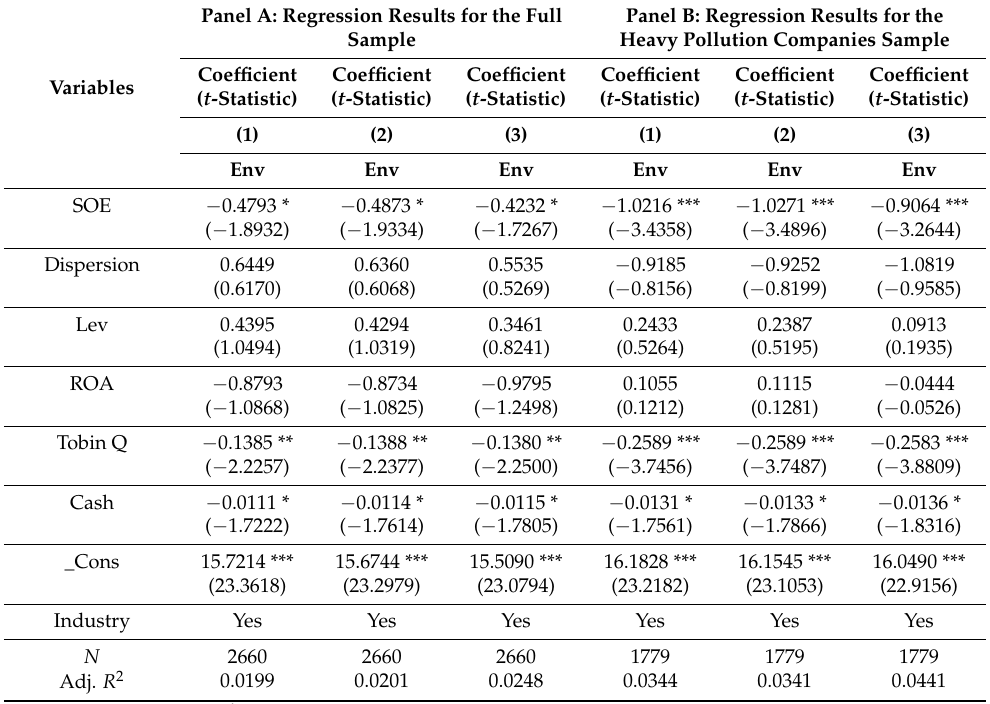
Panel B: Regression Results for the Heavy Pollution Companies